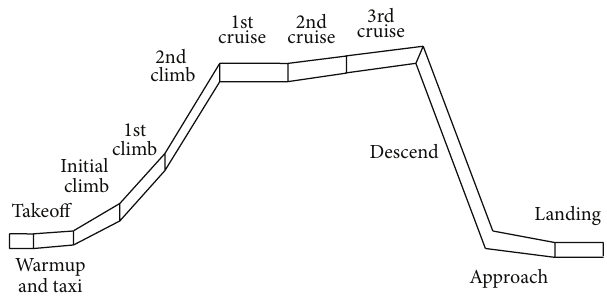
Figure 1: Aircraft design mission